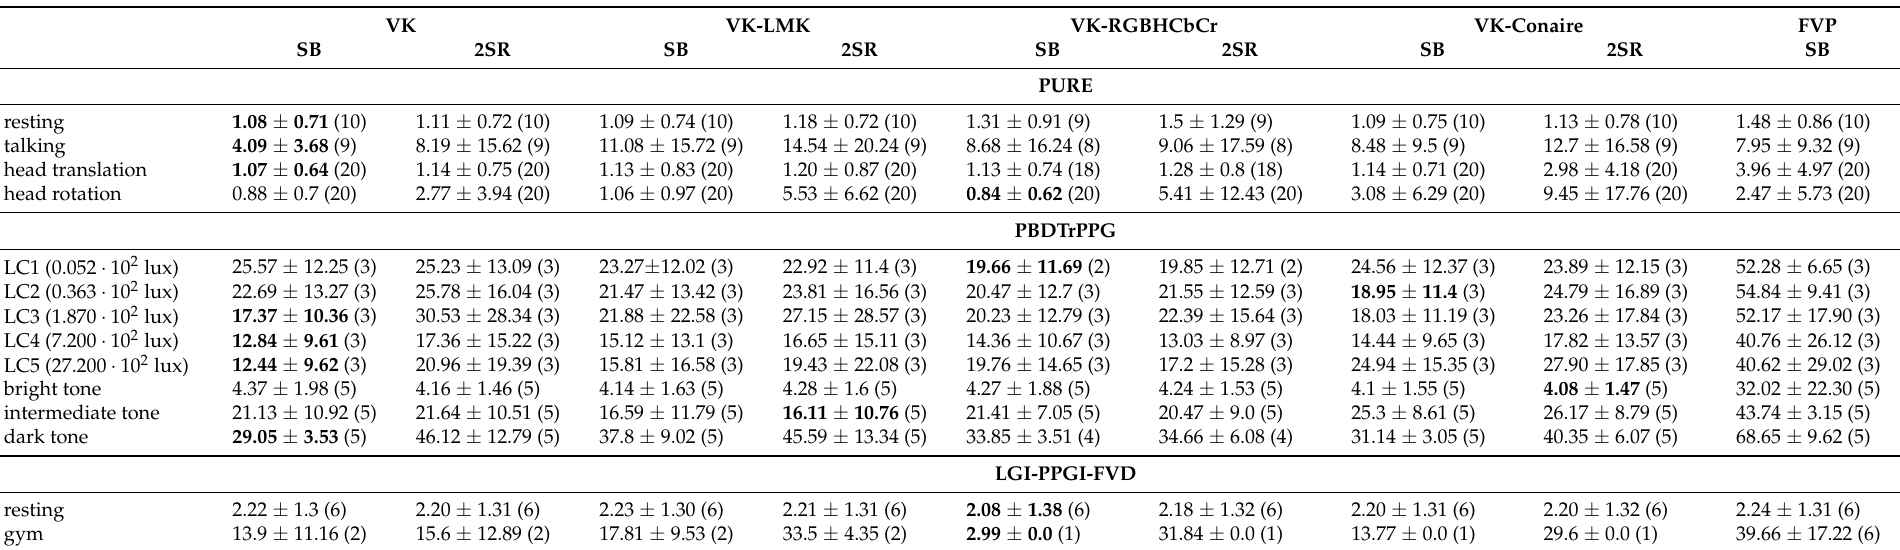
Table 3. Performance of the studied approaches with and without image processing front-end in terms of RMSE (expressed as a mean ± standard deviation; measured in BPM) for PURE, PBDTrPPG and LGI–PPGI–FVD. The lowest RMSE values for each recording scenario are denoted in bold; the values in parentheses denote the number of samples in each group. VK: Viola-Jones combined with ROI width reduction and Kanade–Lucas–Tomasi tracker; VK-Conaire: Viola-Jones combined with skin detector based on the maximization of mutual information and Kanade–Lucas–Tomasi tracker; VK-LMK: Viola-Jones combined with landmarks detection and Kanade–Lucas–Tomasi tracker; VK-RGBHCbCr: Viola-Jones combined with RGB–H–CbCr skin-color segmentation and Kanade–Lucas–Tomasi tracker; FVP: Full Video Pulse Extraction rPPG algorithm. VK